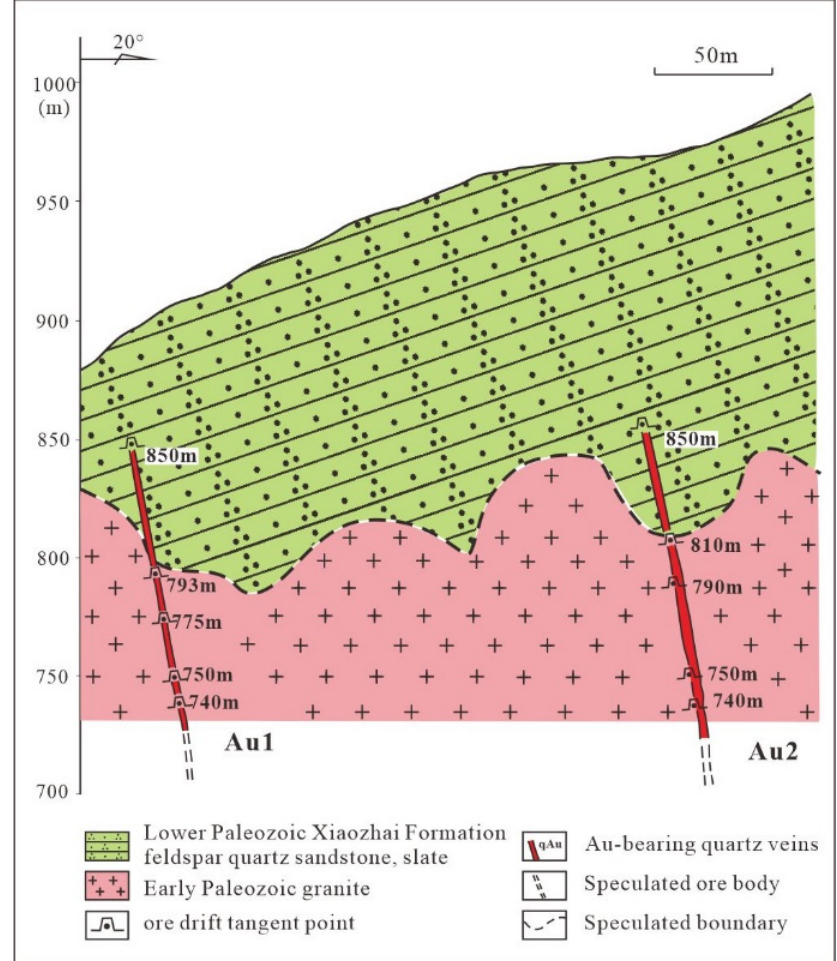
Figure 4. Xinping profile of tunnel control of the Au-bearing quartz veins in the Jianbeigou gold deposit (Modified form [40]).